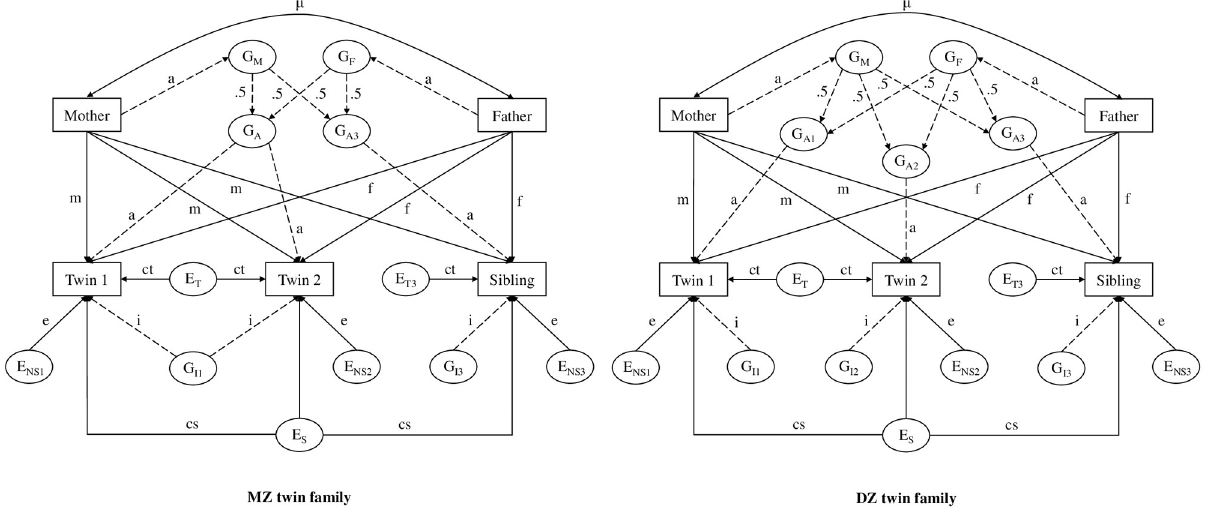
Fig 1. Nuclear twin family design model. G, genetic factors; E, environmental factors; dotted lines, genetic paths; a, additive genetic effects; i, non- additive genetic effects; m, environmental transmission from mother to offspring; f, environmental transmission from father to offspring; cs, environmental effects shared by siblings; ct, environmental influences shared by twins; e, unique environmental influences (including measurement error); μ , parent’s phenotypic similarity.